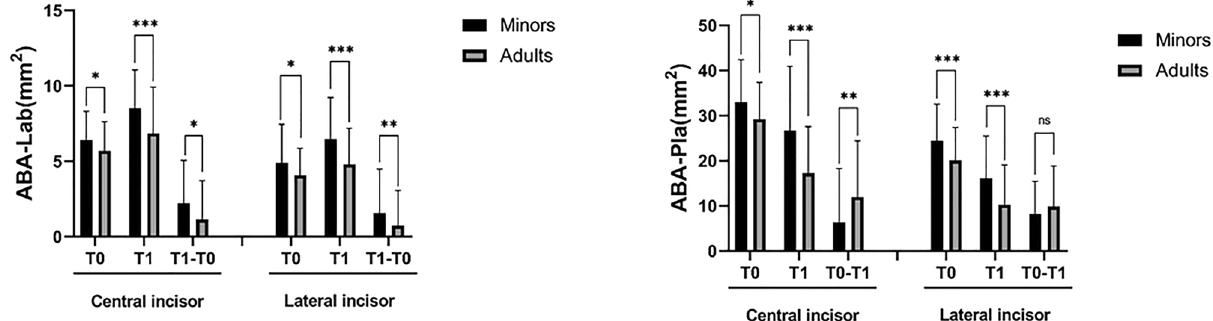
Figure 3. Changes in the labial and palatal alveolar bone area in central incisors and lateral incisors before (T0) and after treatment (T1). *, P < 0.05; **: P < 0.01, ***, P <